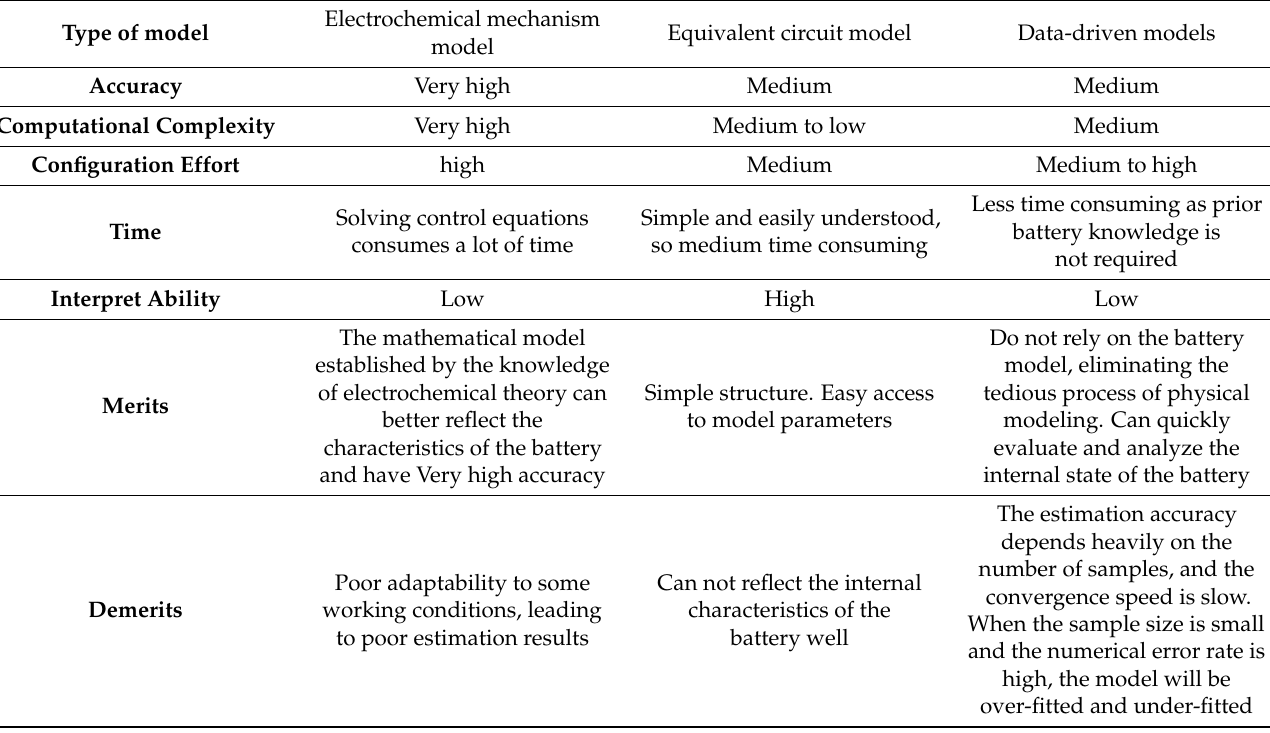
Table 2. Battery model comparison.